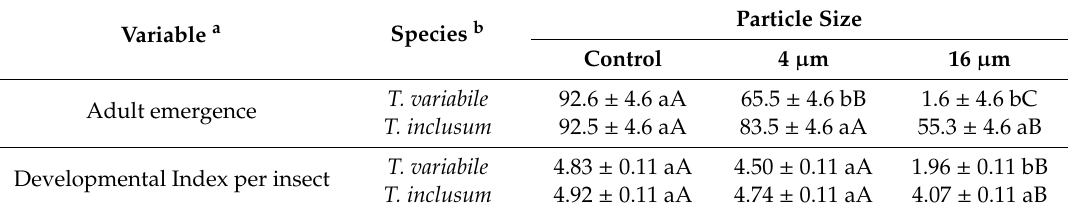
Table 3. Percent adult emergence and developmental index of dermestids in pyrethrin + methoprene aerosol treated concrete arenas after late larvae were released in arenas at week three following the application of aerosol and storage of arenas in incubators at di ff erent temperature treatments.